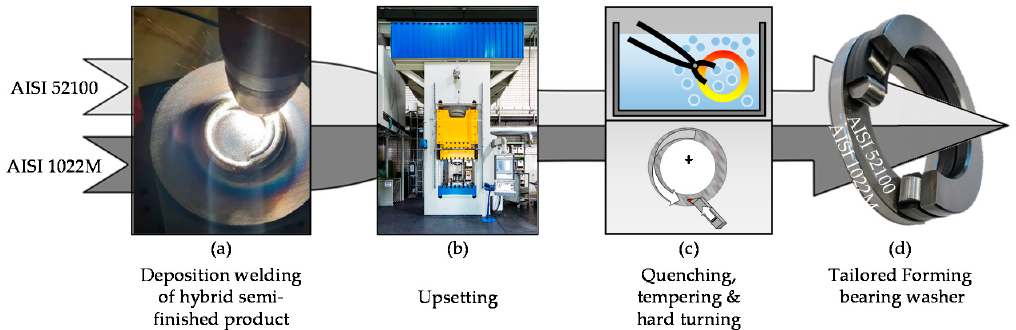
Figure 1. Process chain for manufacturing a hybrid cylindrical roller thrust bearing washer by tailored forming: ( a ) plasma-transferred arc deposition welding; ( b ) upsetting; ( c ) heat treatment by quenching, tempering, and subsequent mechanical processing; ( d ) bearing assembly for analysis in a test bench.